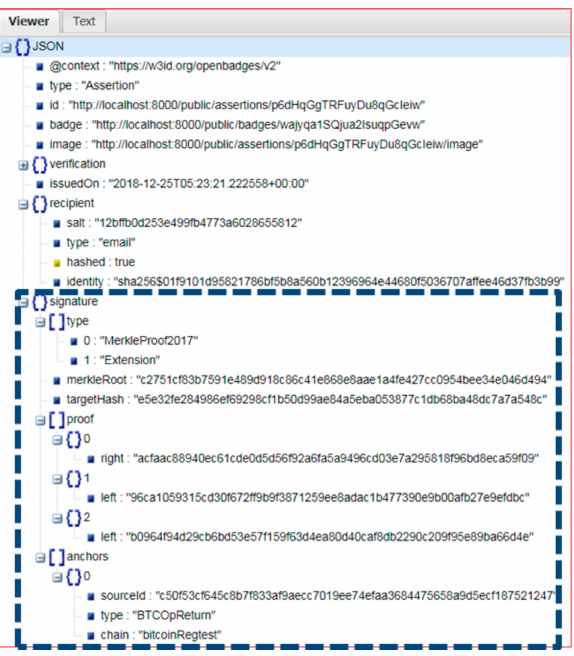
Figure 8. Digital badge assertion information with extension of blockchain in this